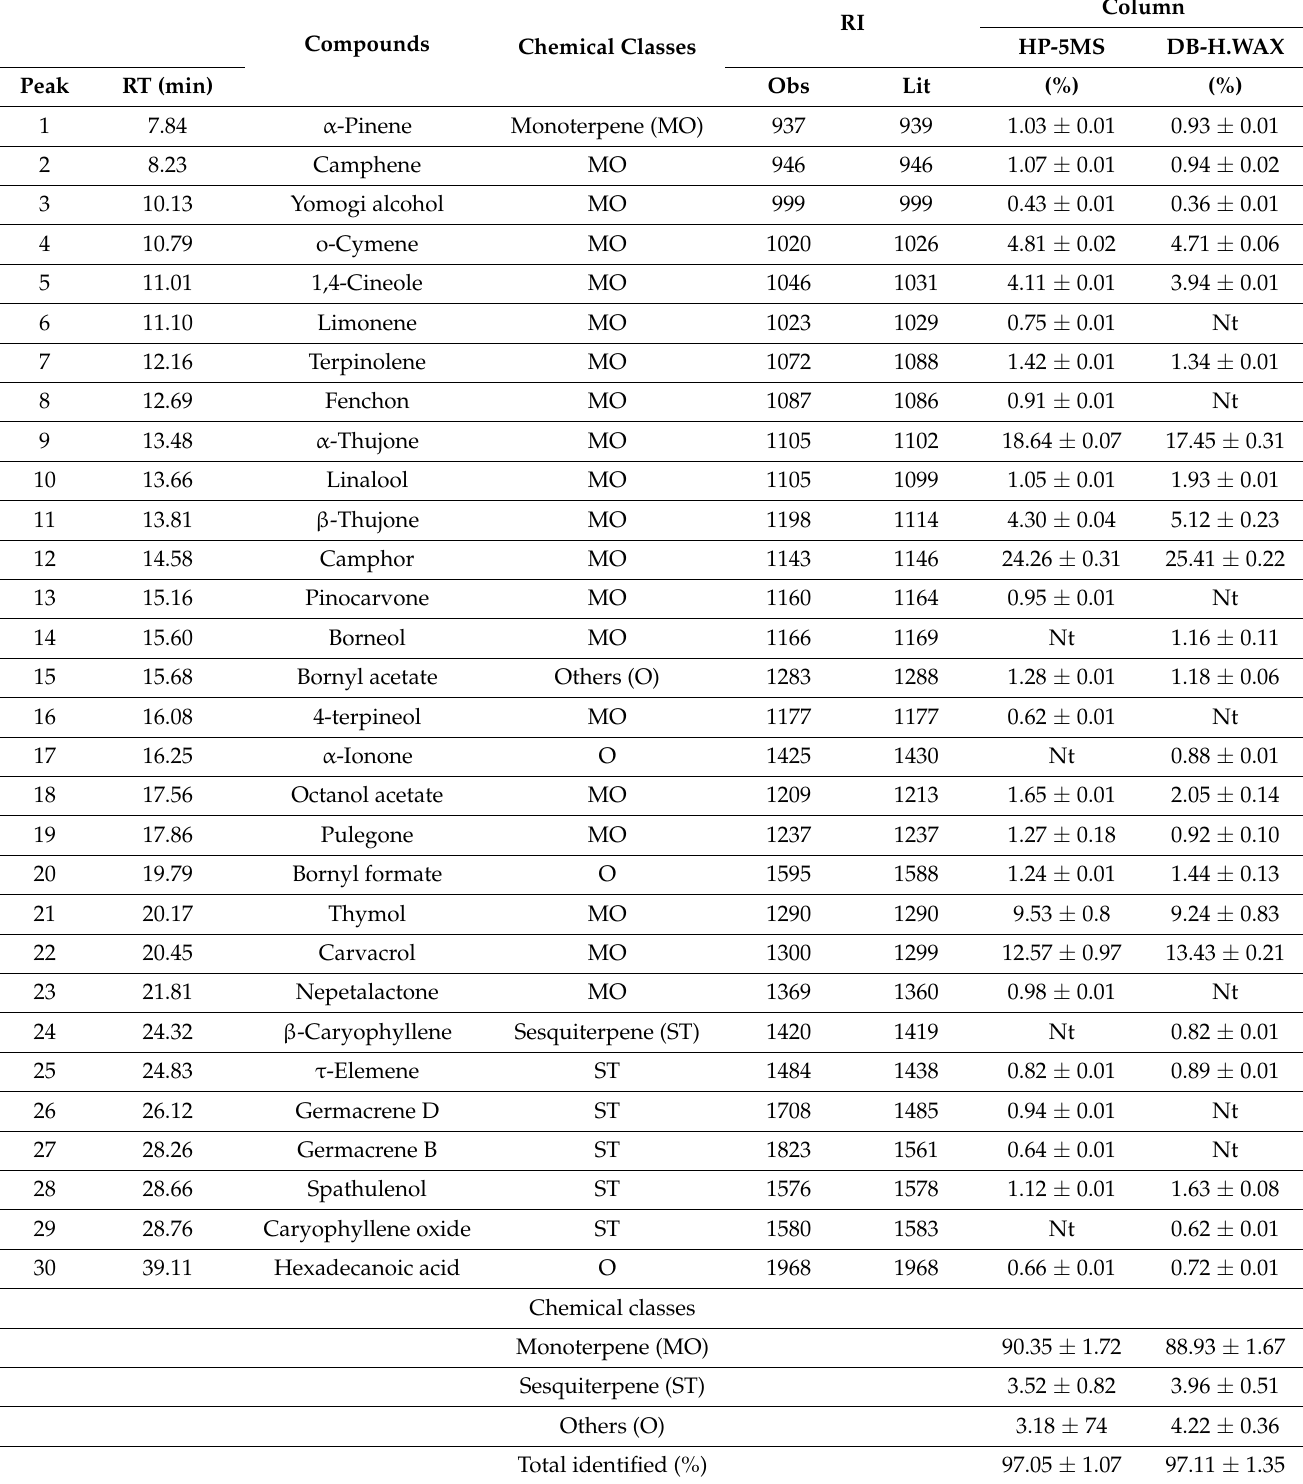
Table 1. Phytochemical compounds contained in the essential oil of W. frutescens